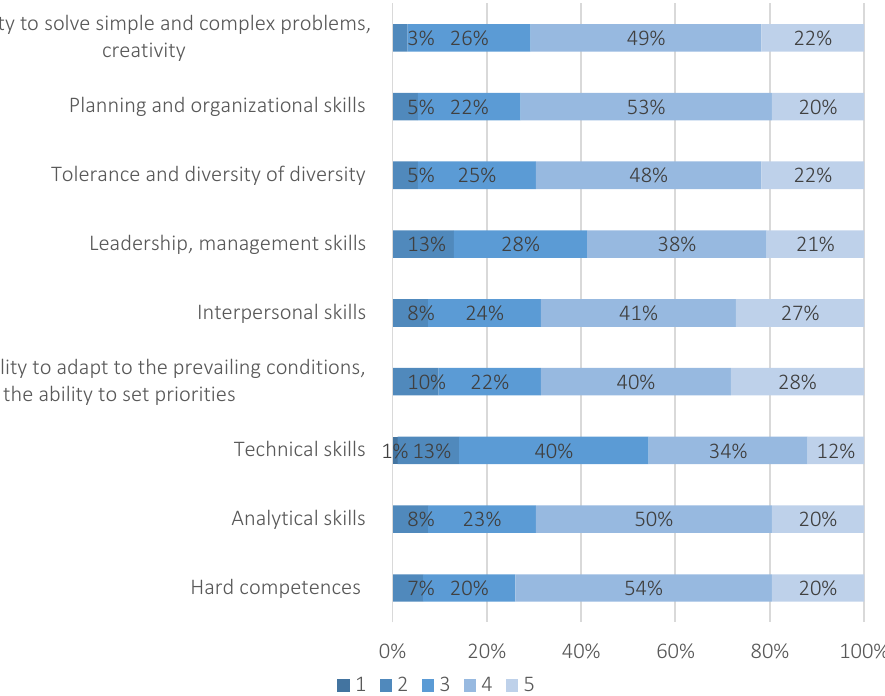
Figure 2. Aggregated components of employee competencies